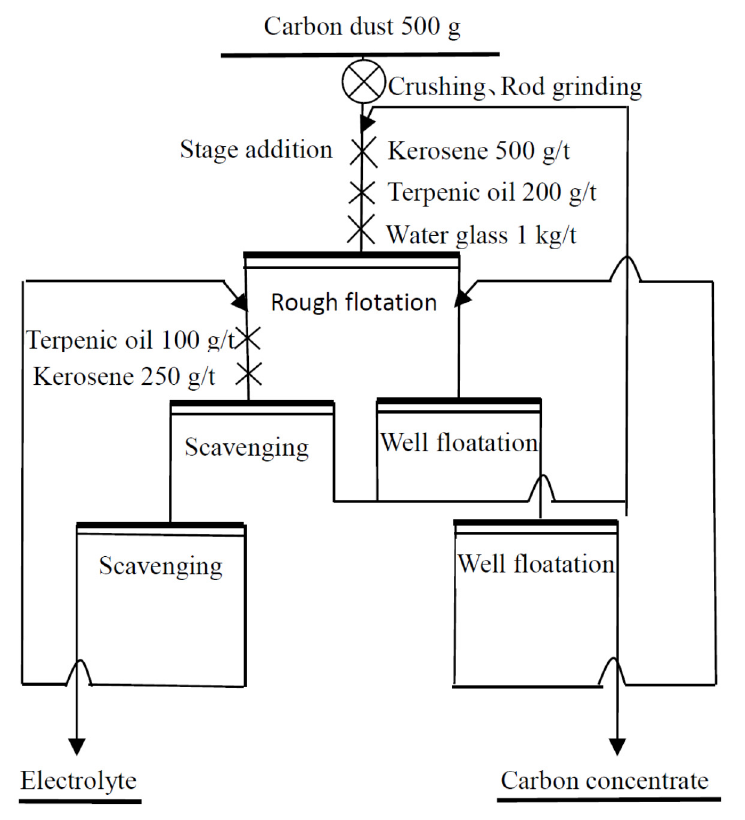
Figure 5. Comparison experiment flow chart.